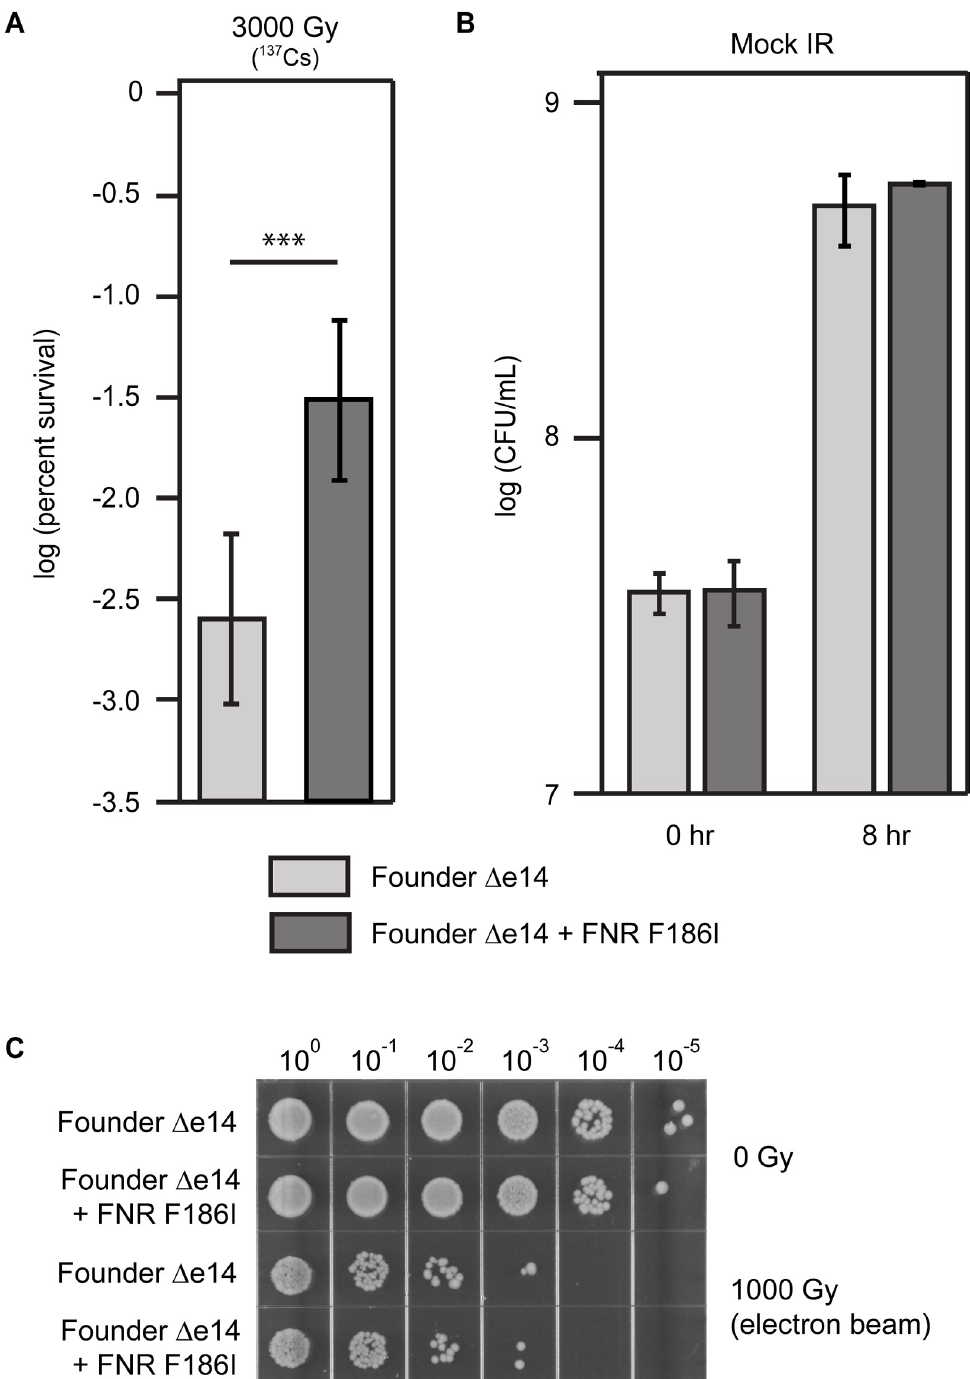
Fig 1. The FNR F186I variant increases resistance to γ -ray IR. A) The FNR F186I allele increases survival of cells exposed to γ -ray IR at a dose rate of ~ 6.5 Gy/min. The Y axis represents percent survival. Strains were assayed for survival of exposure to 3,000 Gy at exponential phase growth as described in the Materials and Methods section. The FNR F186I variant was moved from the IR-resistant isolate CB3000 into the Founder Δ e14 background as previously described [6, 12]. The results represented indicate the average percent survival of 54 (Founder Δ e14) and 23 (Founder Δ e14 + FNR F186I) biological replicates. Error bars represent the standard deviation. The difference between the average of each strain is significantly different (p-value < 10 − 12 ) as calculated with a two-tailed Student’s t-test, as indicated by the ‘ ��� ’ symbol. Raw data for Fig 1A is contained in Supporting Information (S1 File. IR resistance assays survival data). B) The FNR